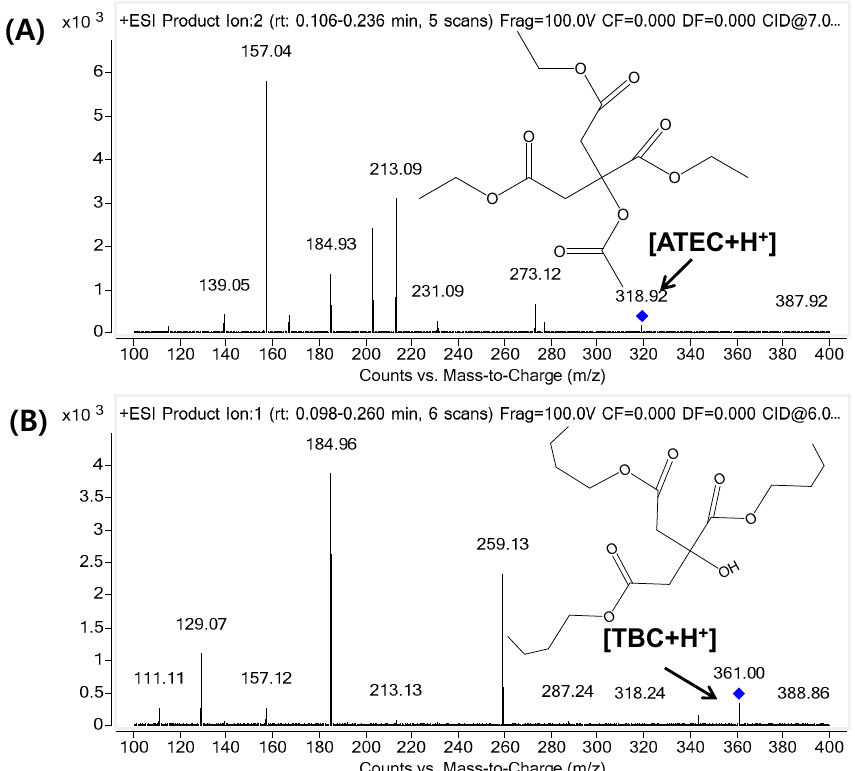
Figure 1. Product ion spectrum of ( A ) Acetyl triethyl citrate (ATEC) and ( B ) tributyl citrate internal standard (TBC IS) .